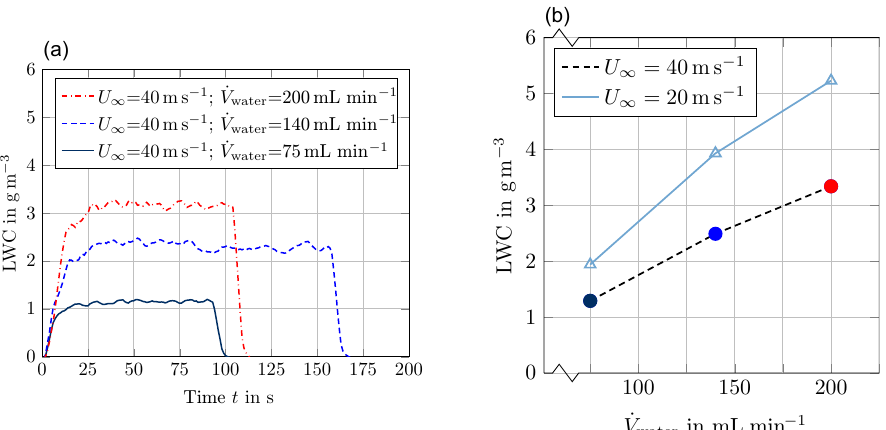
Figure 21. Liquid water content calibration at the tunnel centreline based on IKP measurements, (a) LWC history and (b) LWC depending on supplied water flow rate ˙ V water .